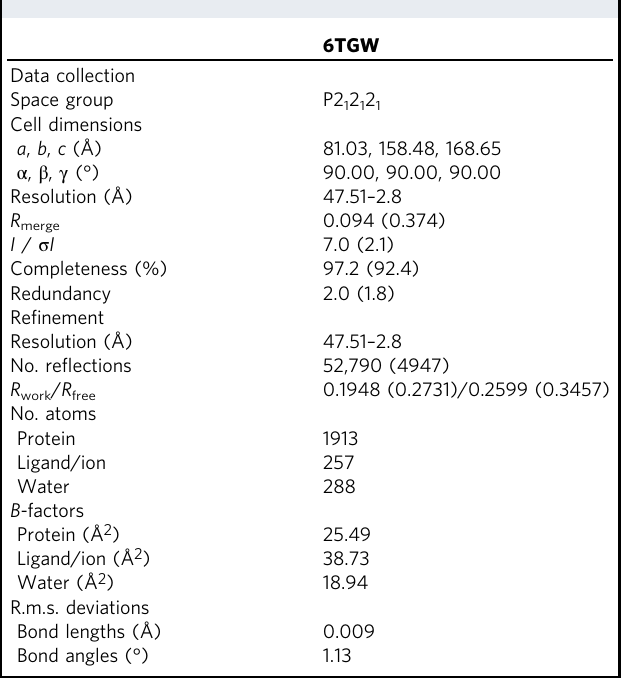
Fig. 6 Discovery of a selective ALDH1A3 inhibitor by in silico screening. a X-ray crystal structure of human ALDH1A3 (in pink) in complex with MCI-INI- 3 (in black) (PDB code 6TGW). Key interacting residues are shown in sticks. Dashed lines represent hydrogen bonds. b Superposition of the ALDH1A3 crystal structure (orange, PDB code: 5FHZ) with the predicted pose of MCI-INI-3 (in gray) and the co-crystal structure of ALDH1A3 with MCI-INI-3. c – e Superposition of the MCI-INI-3 inhibitor as observed in the ALDH1A3 co-crystal to the structure of ALDH1A1 (in green, PDB code: W4J9), ALDH2 (in magenta, PDB code: 3N80) and ALDH3A1 (in cyan, PDB code: 3SZA), respectively. The dashed circles highlight the con fl icts of MCI-INI-3 with other ALDHs. Images were prepared using the program PyMol. Table 1 Data collection and re fi nement statistics.